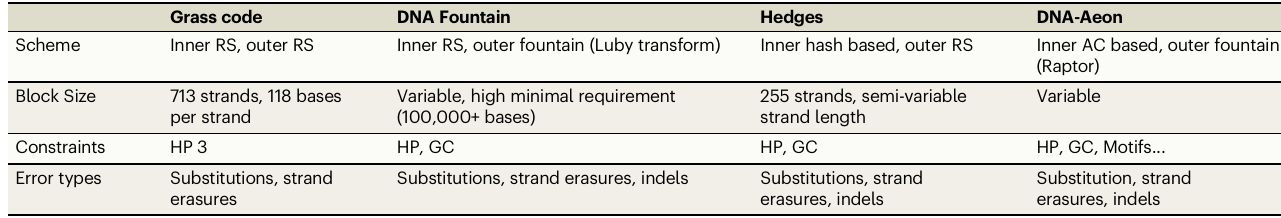
Table 1 | Feature overview of the code implementations evaluated in our work Grass code DNA Fountain Hedges